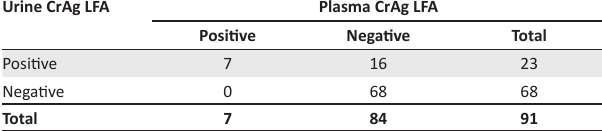
TABLE 3: Sensitivity and specificity of urine cryptococcal antigen lateral flow assay compared with the plasma cryptococcal antigen lateral flow assay for patients with a CD4 count < 100 cells/mm 3 , Eswatini, August 2014 to March 2015. Urine CrAg